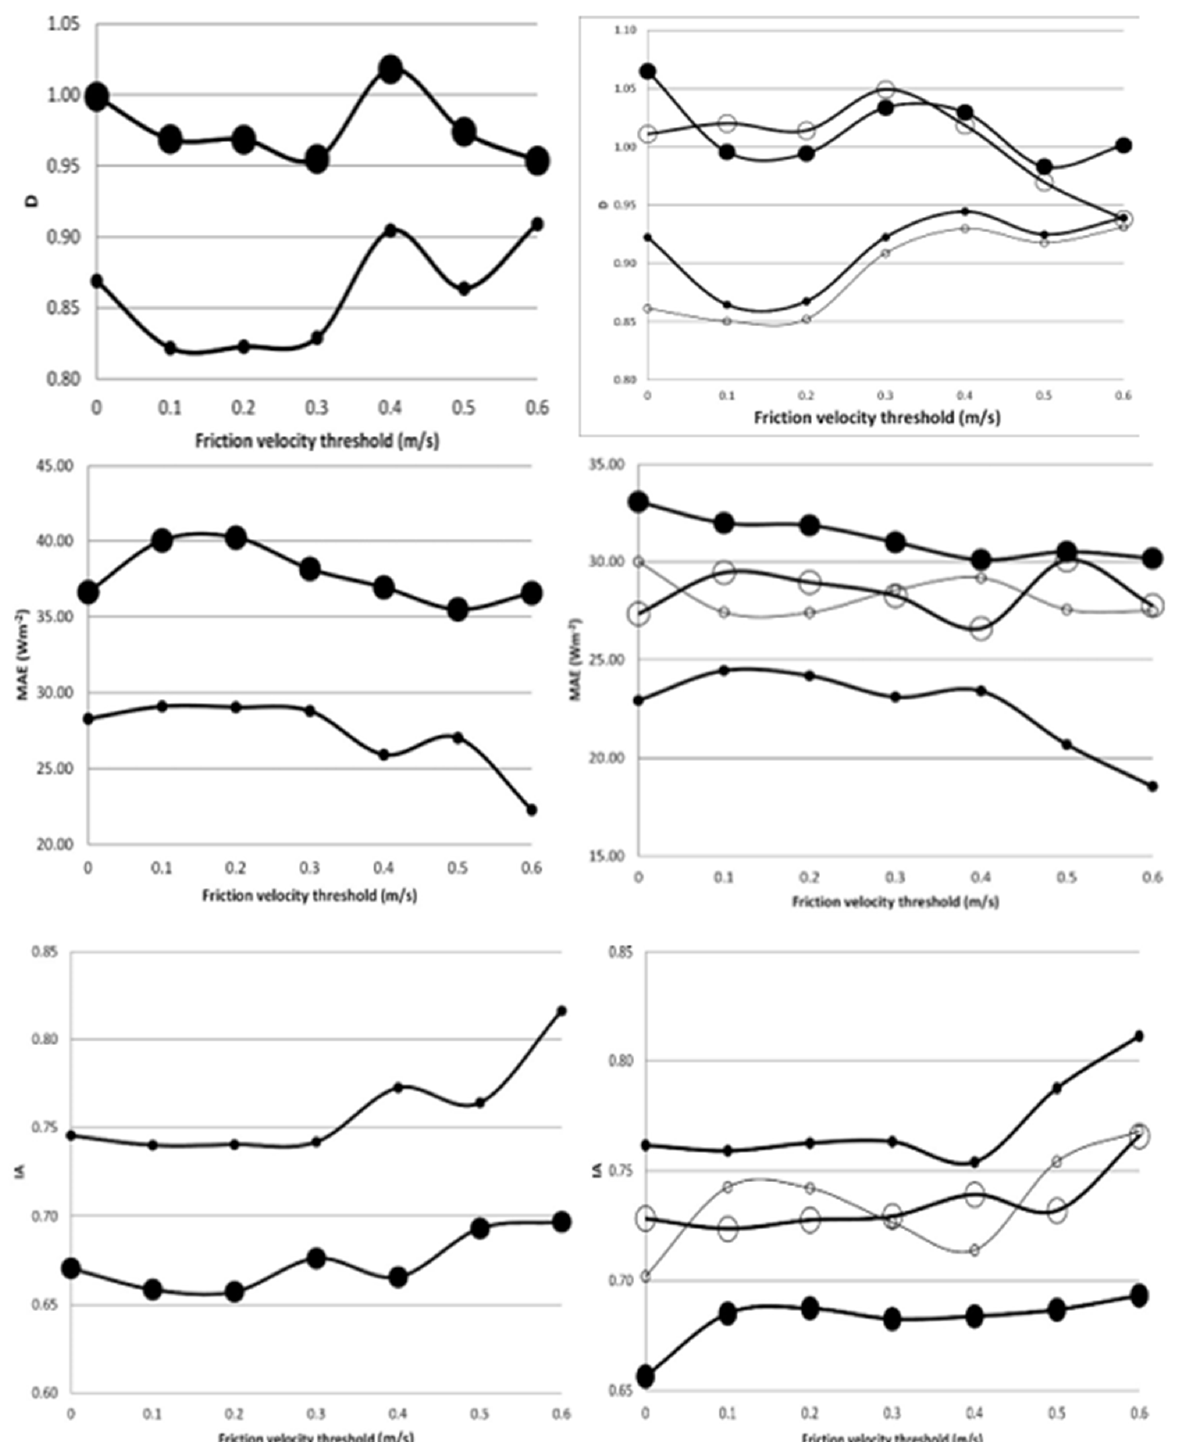
Figure 3. Coefficients D (top), MAE (middle) and IA (bottom) for sensible heat flux estimates using the EC method (thin solid) and the LST method (thick solid) for different friction velocity thresholds in clear sky days (open circle) and cloudy days (solid circle) in July (left panel) and August (right panel).